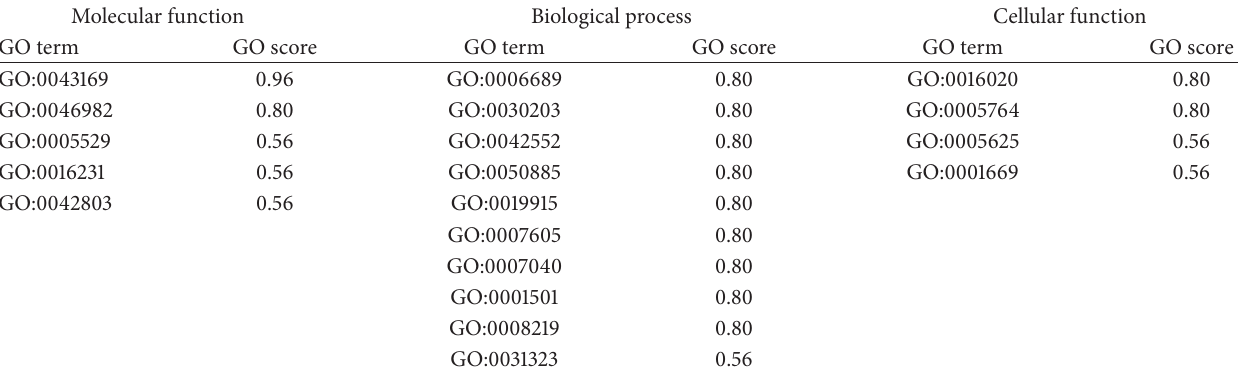
Table 5: Consensus prediction of gene ontology terms searched by COFACTOR. Molecular function Biological